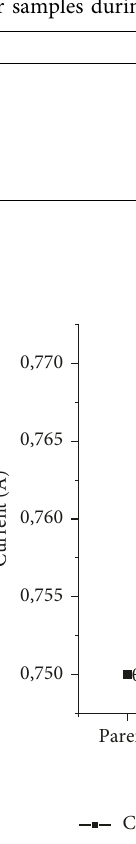
Figure 7: Electrical conductivity result per